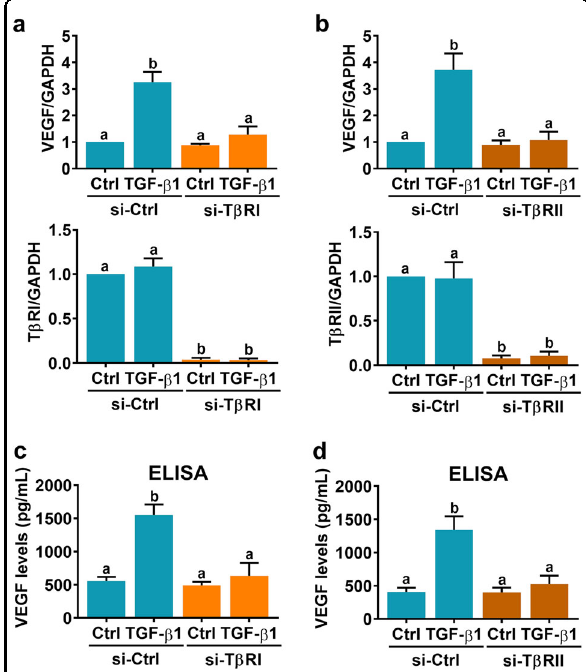
Fig. 3 Knockdown of TGF- β receptor I and II blocks TGF- β 1- induced VEGF expression and secretion. a , b SVOG cells were transfected with 50 nM control siRNA (si-Ctrl), TGF- β receptor I siRNA (si-T β RI) ( a ) or TGF- β receptor II siRNA (si-T β RII) ( b ), and after 48 h they were treated with 5 ng/mL TGF- β 1 for 6 h. VEGF, T β RI, and T β RII mRNA levels were examined by RT-qPCR. c , d SVOG cells were transfected with 50 nM control siRNA (si-Ctrl), TGF- β receptor I siRNA (si-T β RI) ( c ) or TGF- β receptor II siRNA (si-T β RII) ( d ), and after 48 h they were treated with 5 ng/mL TGF- β 1 for 24 h. Protein levels of VEGF in culture media were examined by ELISA. The results are expressed as the mean ± SEM of at least three independent experiments. The values without a common letter are signi fi cantly different ( p <